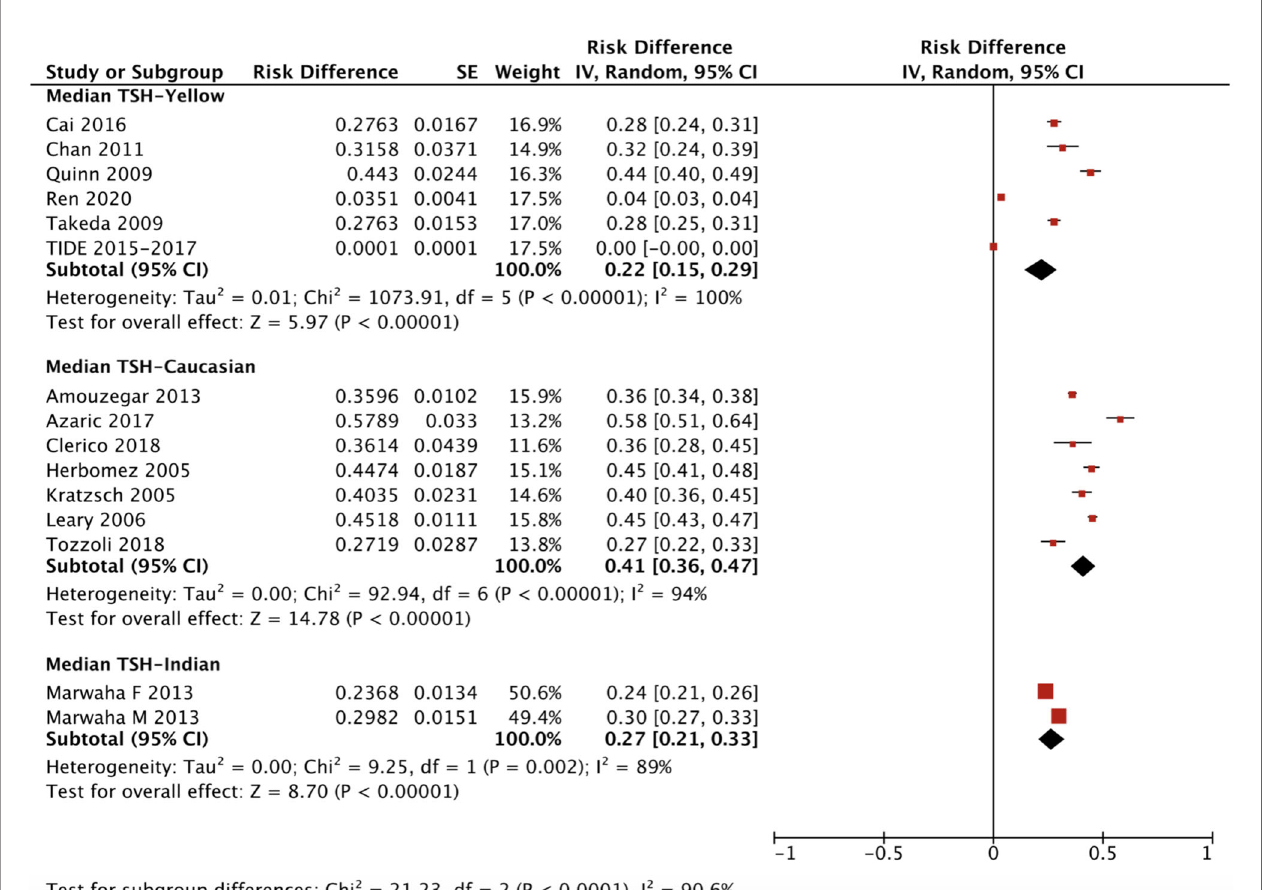
FIGURE 2 | Ethnicity standardized forest plots of the pooled relative descent rate (%) of median TSH (50 th percentile) in NACB populations. F, female; M,